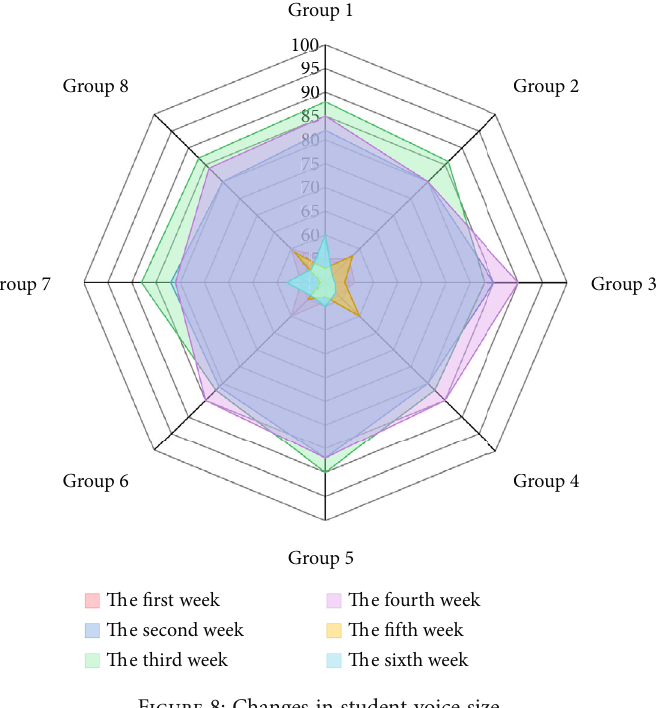
Figure 8: Changes in student voice